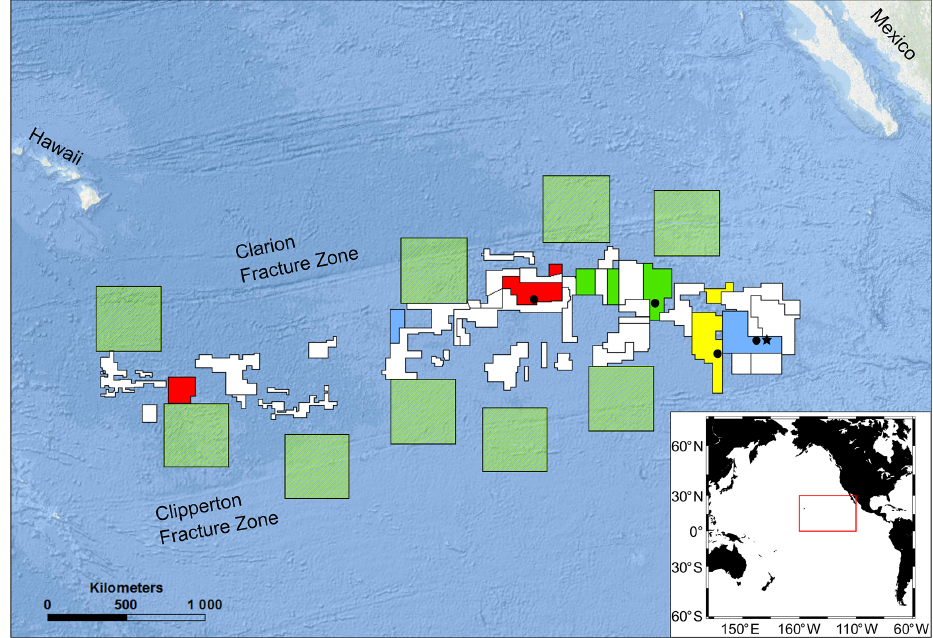
Figure 1. Sampling sites (black circles; black star) in various European contract areas for the exploration of manganese nodules within the Clarion–Clipperton Zone (CCZ). Investigated stations are located in the German BGR area (blue), eastern European IOM area (yellow), Belgian GSR area (green) and French IFREMER area (red). The two stations within the German BGR area are located in the “prospective area” (BGR-PA; black star) and in the “reference area” (BGR-RA; black circle). The contract areas granted and governed by the International Seabed Authority (ISA; white areas) are surrounded by nine areas of particular environmental interest (APEIs), which are excluded from any mining activities (green shaded squares). Geographical data provided by the ISA.